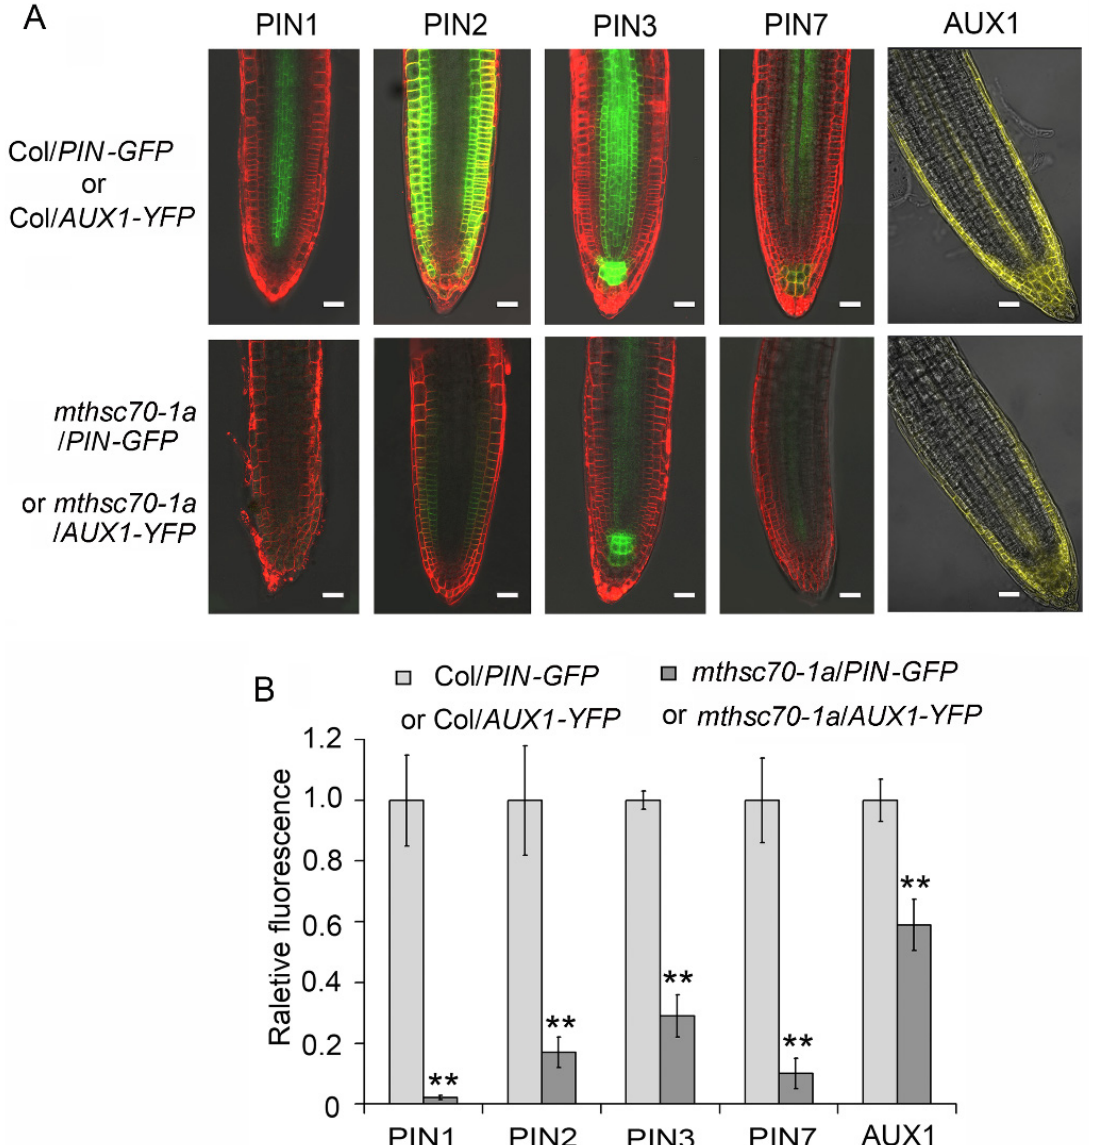
Figure 5. mtHSC70-1 knockout decreased the abundance of auxin transport carriers in root tips. ( A ) The roots of 5 days old transgenic seedlings harboring PIN-GFP were incubated in 5 μ M FM4-64 dye. The fluorescence of the transgenic roots harboring PIN-GFP or AUX1-YFP was observed using a LSCM. Representative images are shown. Scale bar = 20 μ m. ( B ) The fluorescence intensities were visualized with ImageJ 1.42q software (National Institutes of Health, Bethesda, MD, USA). The as- terisks indicate significant differences from Col / PIN-GFP or Col/ AUX1-YFP ( t-test ; **, p < 0.01). Col/ PIN-GFP , Col/ PIN1- , 2- , 3- or 7-GFP plants; mthsc70-1a / PIN-GFP , mthsc70-1a / PIN1- , 2- , 3- or 7- GFP plants; Col/ AUX1-YFP , Col/ AUX1-YFP plants; mthsc70-1a / AUX1-YFP , mthsc70-1a / AUX1-YFP plants.